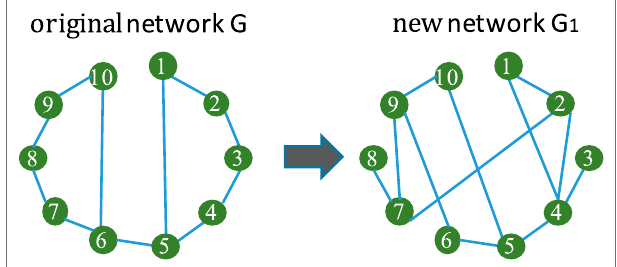
FIGURE 3 | The basic idea of the proposed network rewire mechanism to enhance the robustness of a given complex network. In the proposed rewire mechanism, both edge additions and deletions are allowed without extra